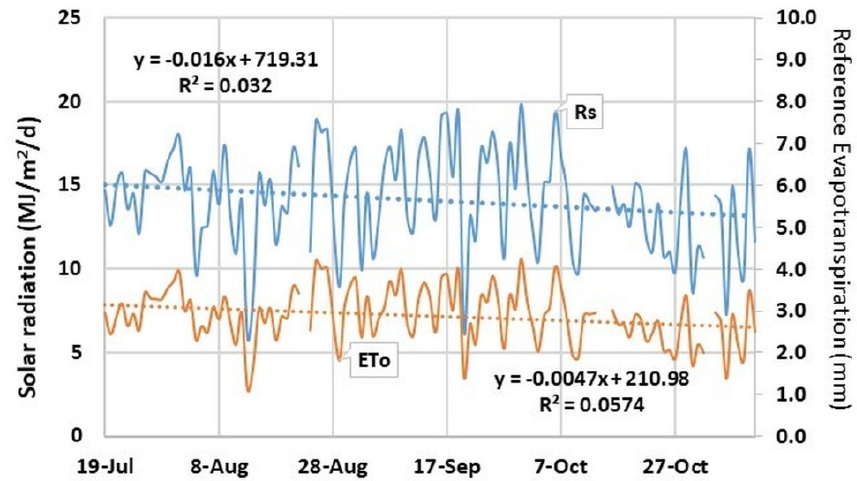
Figure 3. Solar radiation and reference evapotranspiration fluctuation during the planting season.